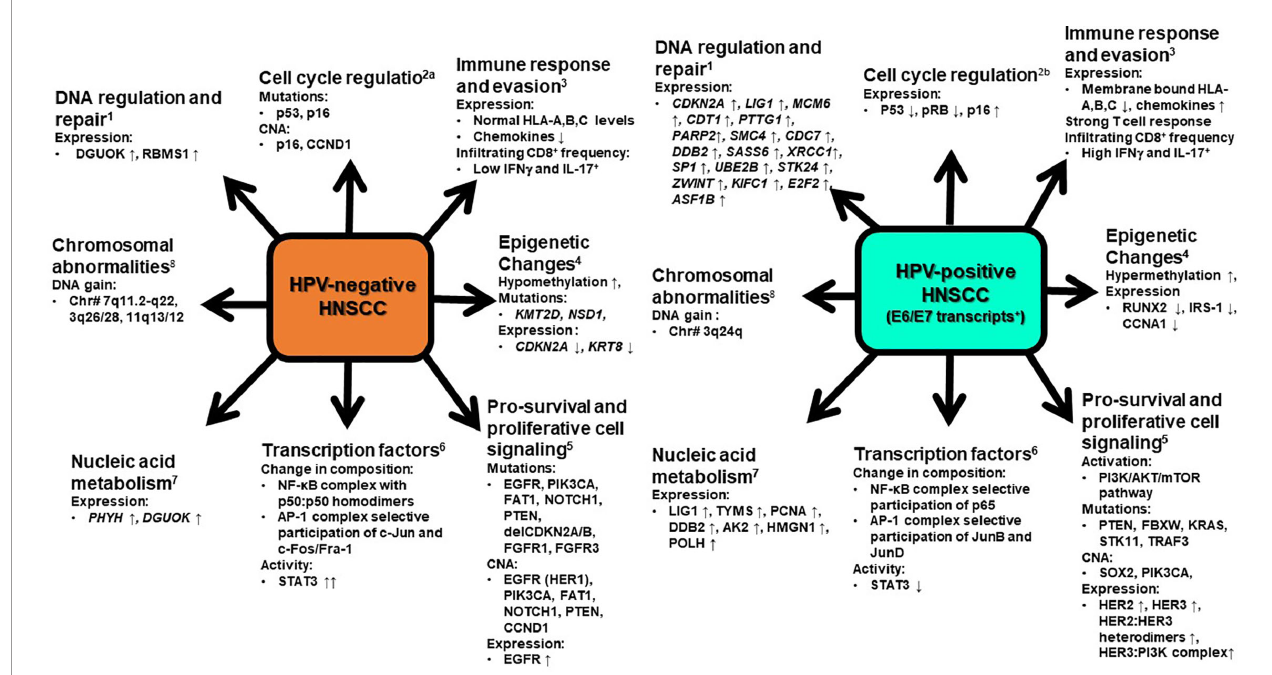
FIGURE 2 | A snapshot of molecular signatures that distinguish HPV-positive and HPV-negative HNSCC. HPV-positive HNSCC that display speci fi ed signatures typically possess transcriptionally-active HPV infections. The changes depicted are characteristically displayed by clinically advanced HNSCC. At an early stage or at the time of viral entry all these changes are not evident in potentially malignant cells. CNA, copy number alterations, ↑ - increase, ↓ -decrease. 1. Upregulation of genes involves in DNA regulation and repair (Lohavanichbutr et al., 2009). 2. Cell cycle regulation (Van Houten et al., 2001; Hafkamp et al., 2003). 3. Varied immune response by HPV positive and HPV negative HNSCC (Nasman et al., 2013; Partlova et al., 2015). 4. Epigenetic changes (Sartor et al., 2011; Lindsay et al., 2017; Leemans et al., 2018) 5. Pro-survival and proliferative cell signaling (Chung et al., 2015; Pollock et al., 2015; Seiwert et al., 2015) 6. Modi fi cation in expression and activation of different transcription factors (Mishra et al., 2006; Gaykalova et al., 2015; Verma et al., 2017; Gupta et al., 2018). 7. Upregulation of genes involved in nucleic acid metabolism (Lohavanichbutr et al., 2009). 8. Gain in DNA of chromosome (Dahlgren et al., 2003).